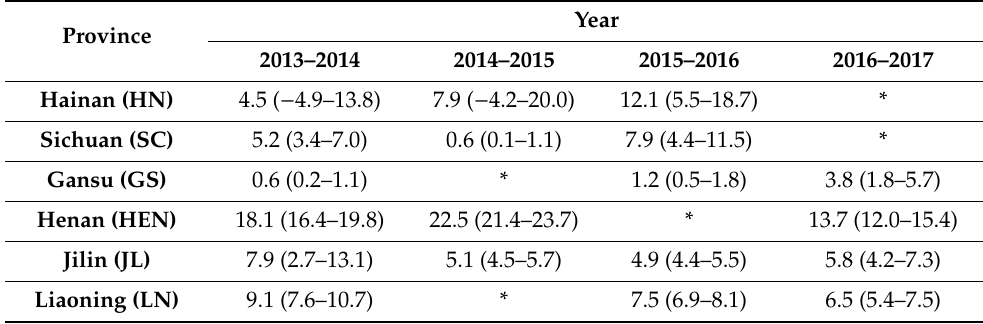
Table 2. Annual total winter losses (%, CI 95%) in Hainan (HN), Sichuan (SC), Gansu (GS), Henan (HEN), Jilin (JL), Liaoning (LN)